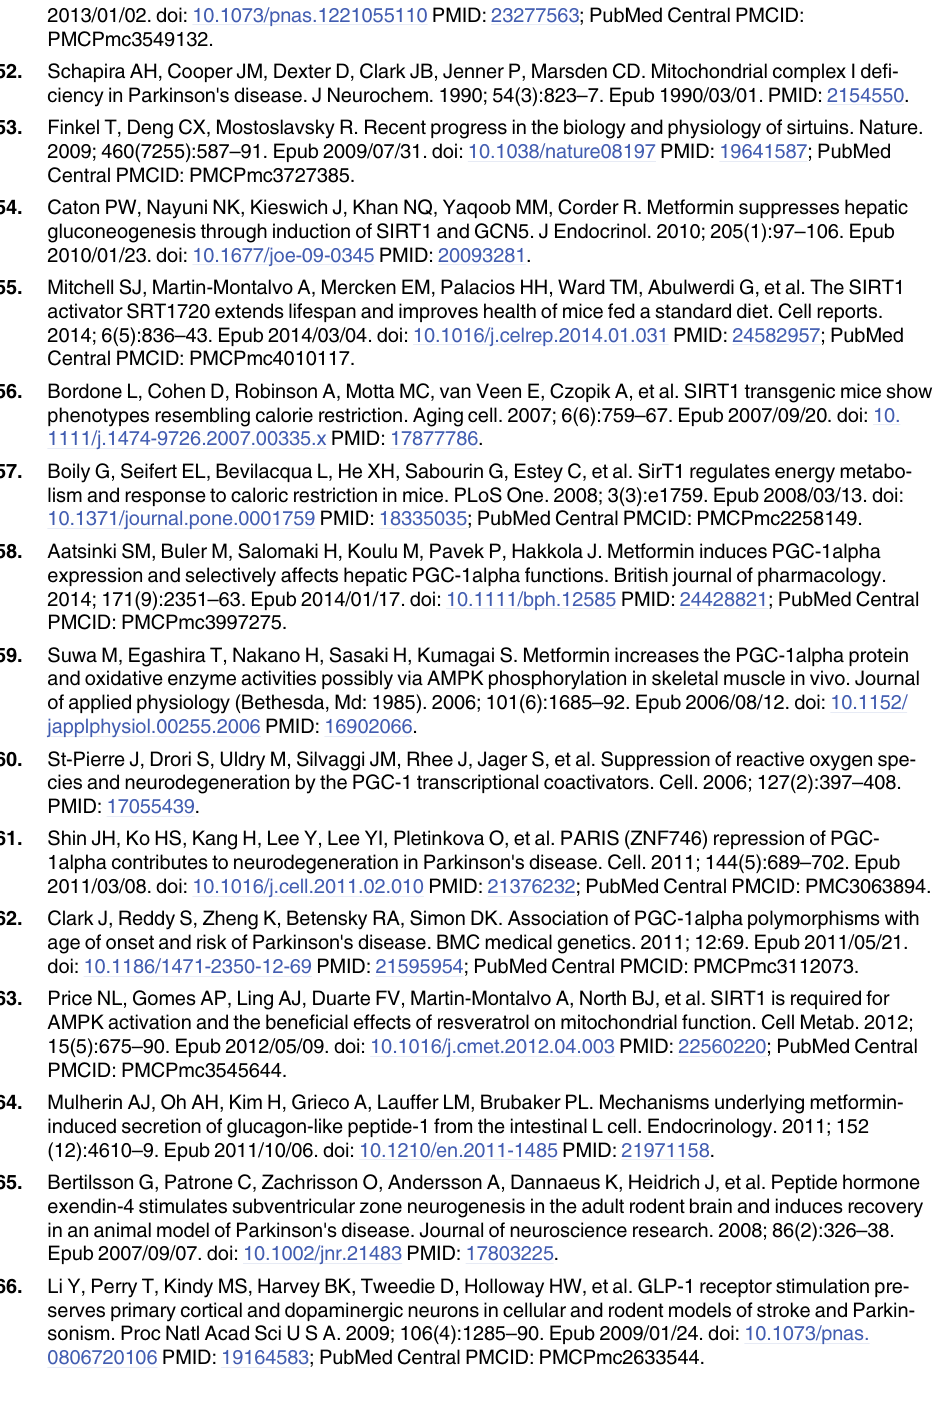
PLOS ONE | DOI:10.1371/journal.pone.0159381 July 28,